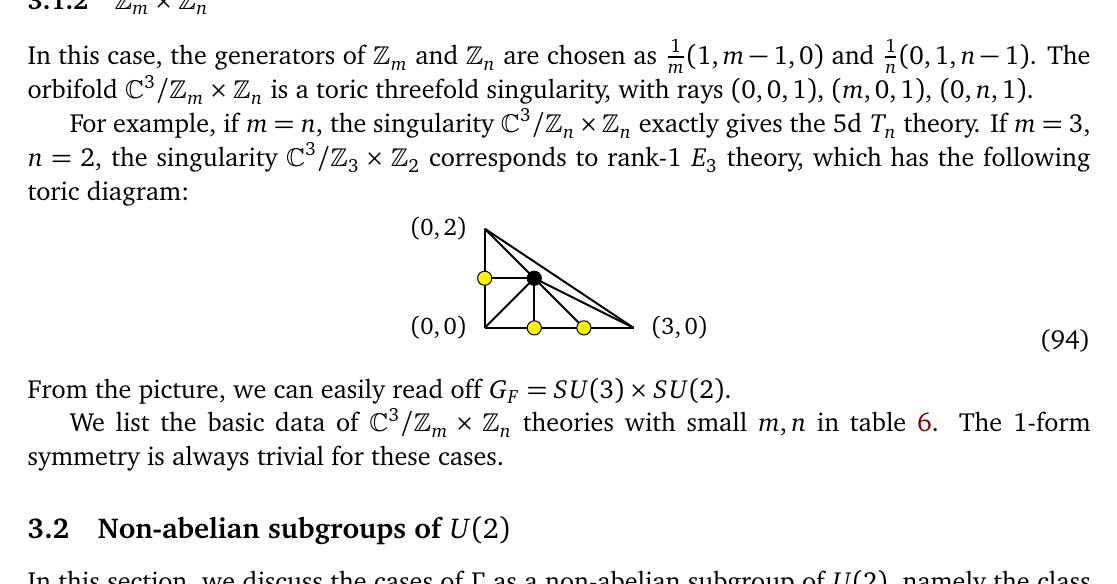
× (cid:90) with their r , f , UV flavor symmetry G m n